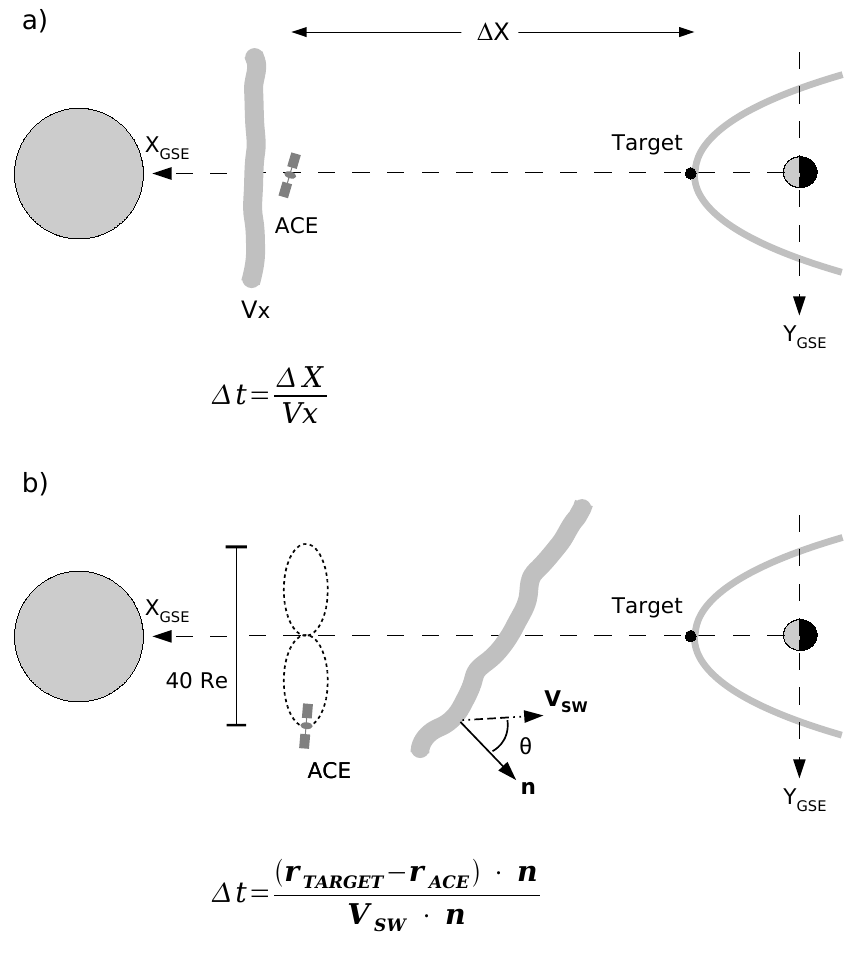
Fig. 1. Illustration of the two principal methods to calculate the solar wind propagation delay. (a) Flat delay: A planar structure is assumed to propagate with a constant velocity along the Sun-Earth line. Both the solar wind monitor (ACE) and the target (typically the Earth’s upstream magnetopause) are assumed to lie on the Sun-Earth line. (b) The real position of the solar wind monitor as well as the orientation of the IMF phase front, represented by its boundary normal n , and the actual solar wind velocity vector, v sw are taken into account. θ is the angle between the phase front normal and the solar wind velocity (in Weimer et al., 2003, the angle θ is measured between the normal and the Sun-Earth